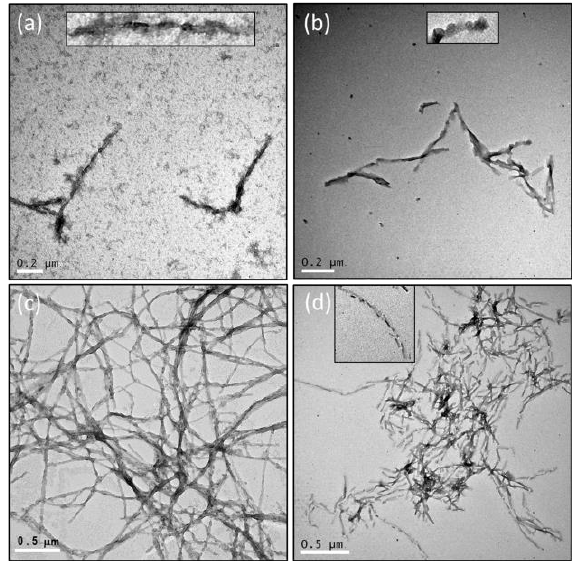
Figure 5. Transmission electron microscopy (TEM) images of fibrils converted from four PrP variants ( a ) PrP- oct, ( b ) PrP-1oct, ( c ) PrP-5oct and ( d ) PrP-8oct.